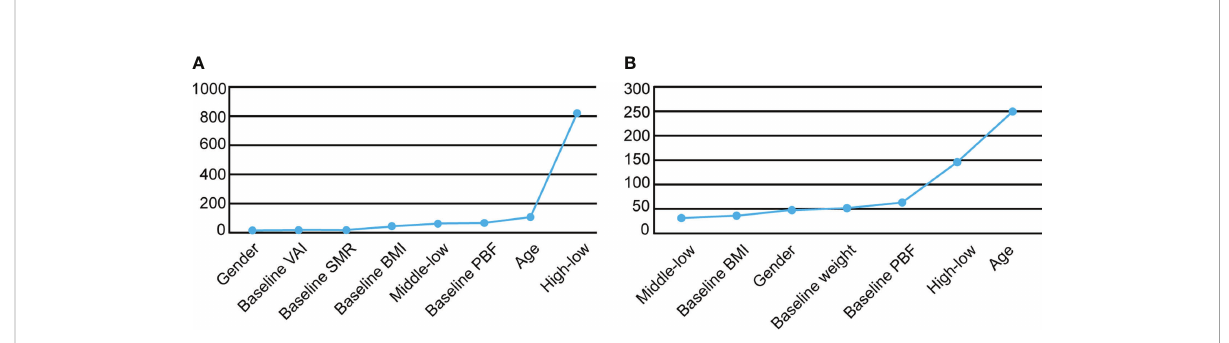
FIGURE 3 The importance of factors in logistic regression model which was measured as the partial chi-square statistic minus the predictor degrees of freedom ( c 2 - df) was shown. (A) c 2 - df values for the prediction of weight loss success in the overweight and obese population with BMI ≥ 24. (B) c 2 - df values for the prediction of effective fat loss in the obese population with normal